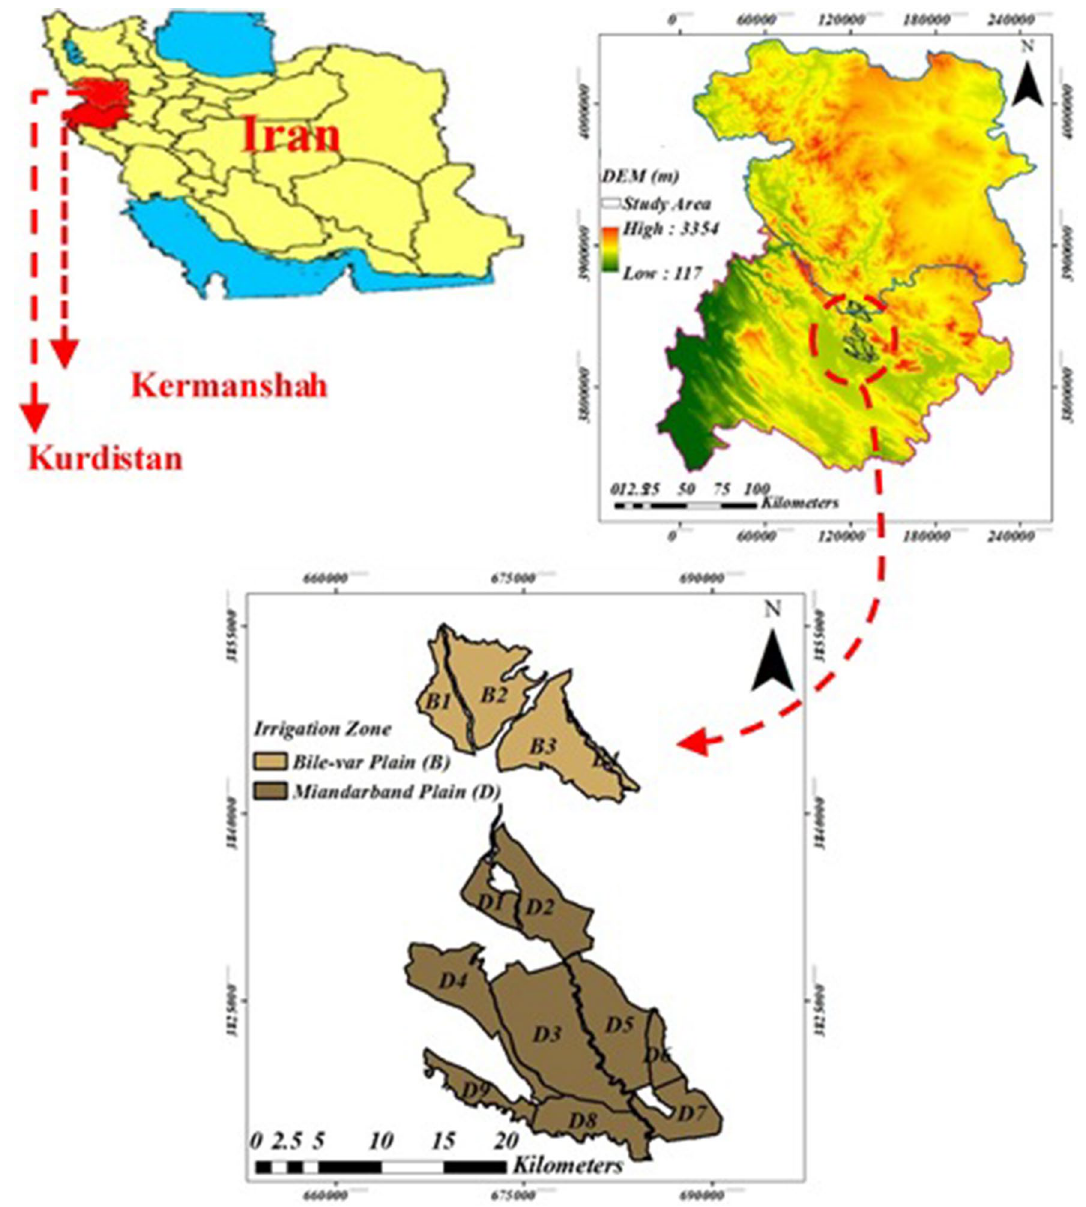
Fig. 1 Location of the study